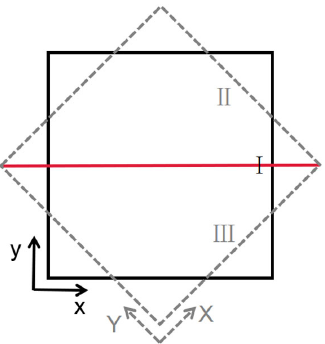
FIG. 7. Sketch of two different open-boundary conditions. The square in black solid lines shows the open boundaries in the (10) and (01) directions, while the square in gray dashed lines shows 1¯1 the open boundaries in the (11) and ð Þ directions. Mirror symmetry is implied by the red line in the